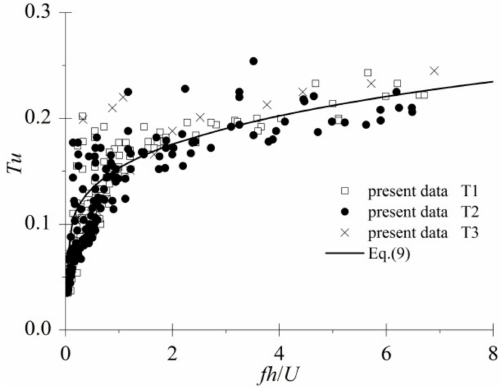
Figure 11. Relationship between turbulence intensity and dimensionless bubble